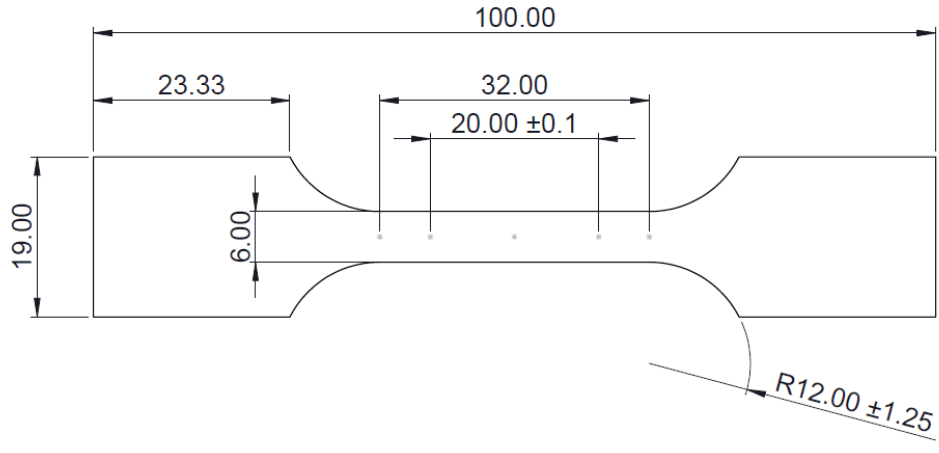
Figure 5. Geometry of tensile specimen based on ASTM-E8/EM (dimensions in mm).